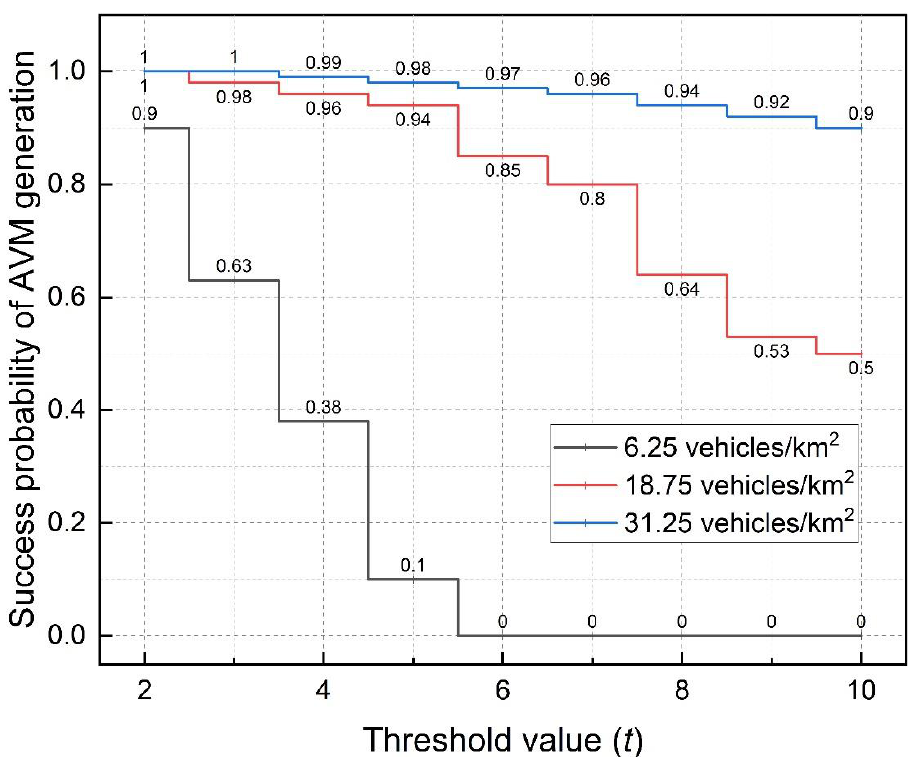
Figure 7. The success probability of an AVM generation.